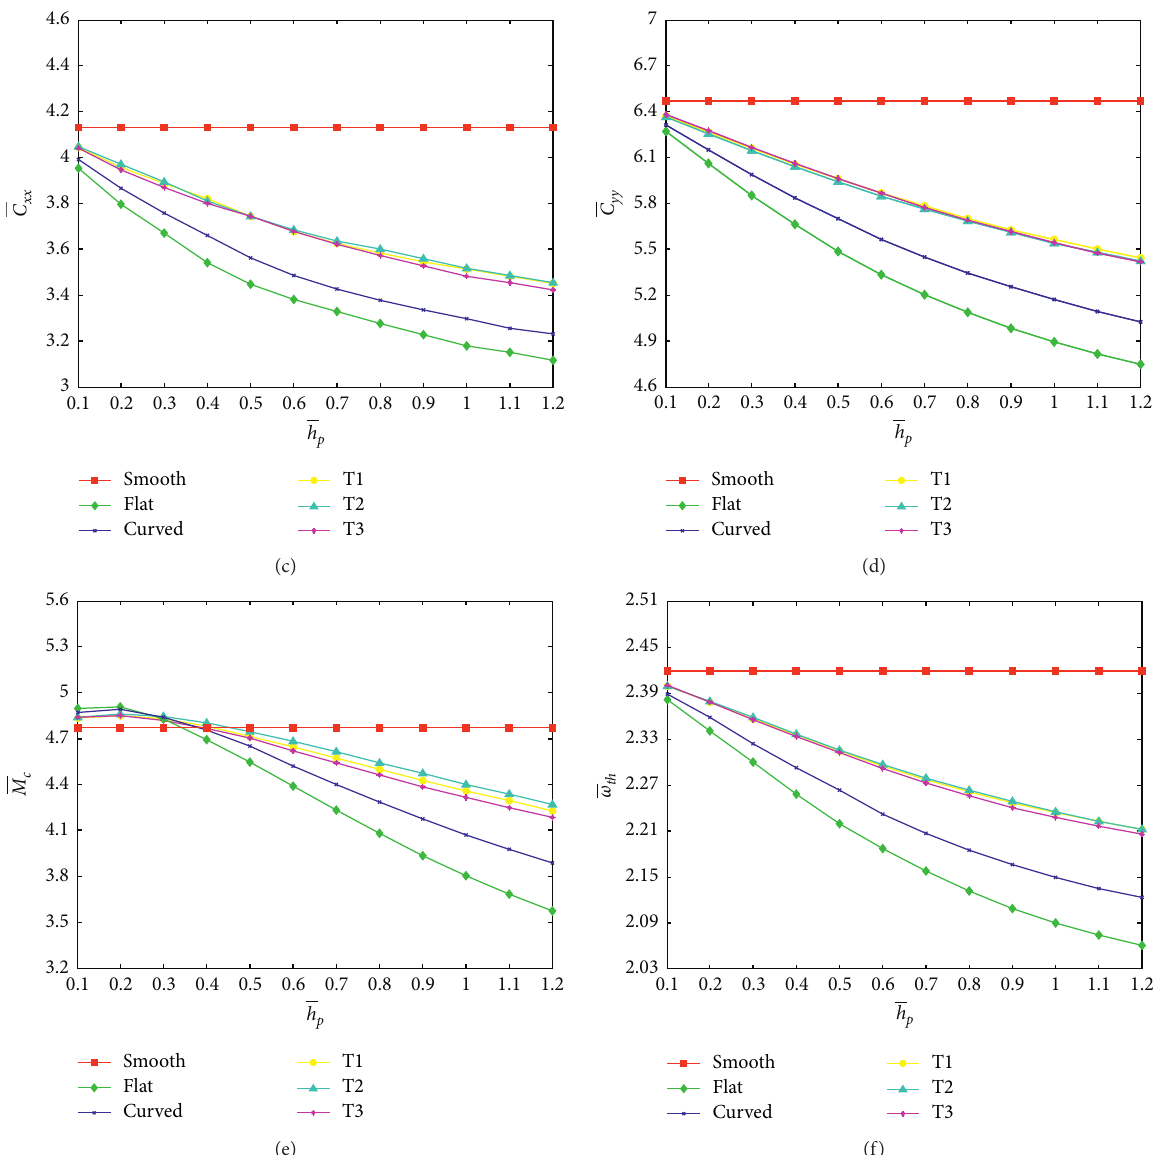
Figure 8: Effect of the texture depth on dynamic and stability performance characteristics for smooth/textured journal bearings: (a) the direct stiffness coefficient ( K ); (b) the direct stiffness coefficient ( K xx ); (e) the critical mass ( M c ); (f) the threshold speed of stability ( ϖ coefficient ( C yy